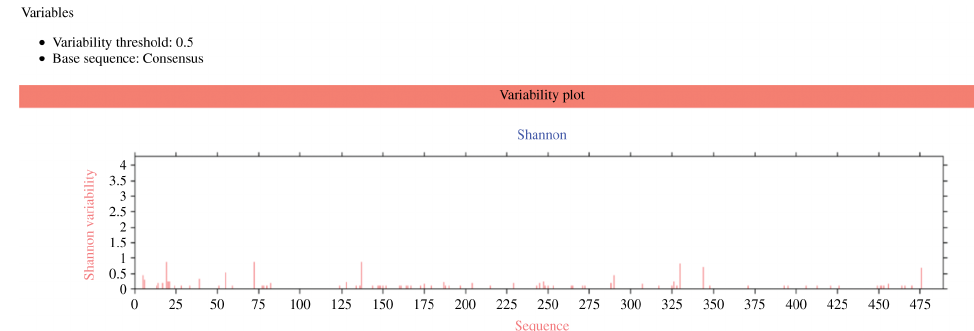
Figure 1: Sequence variability of Envelope Glycoprotein GP62 of